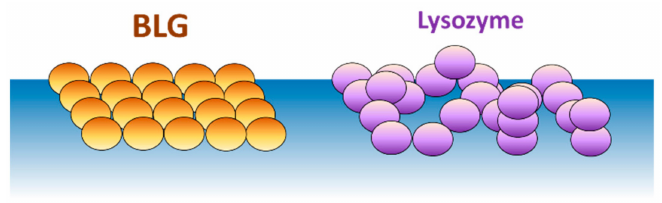
Figure 7. A schematic picture of protein microgel